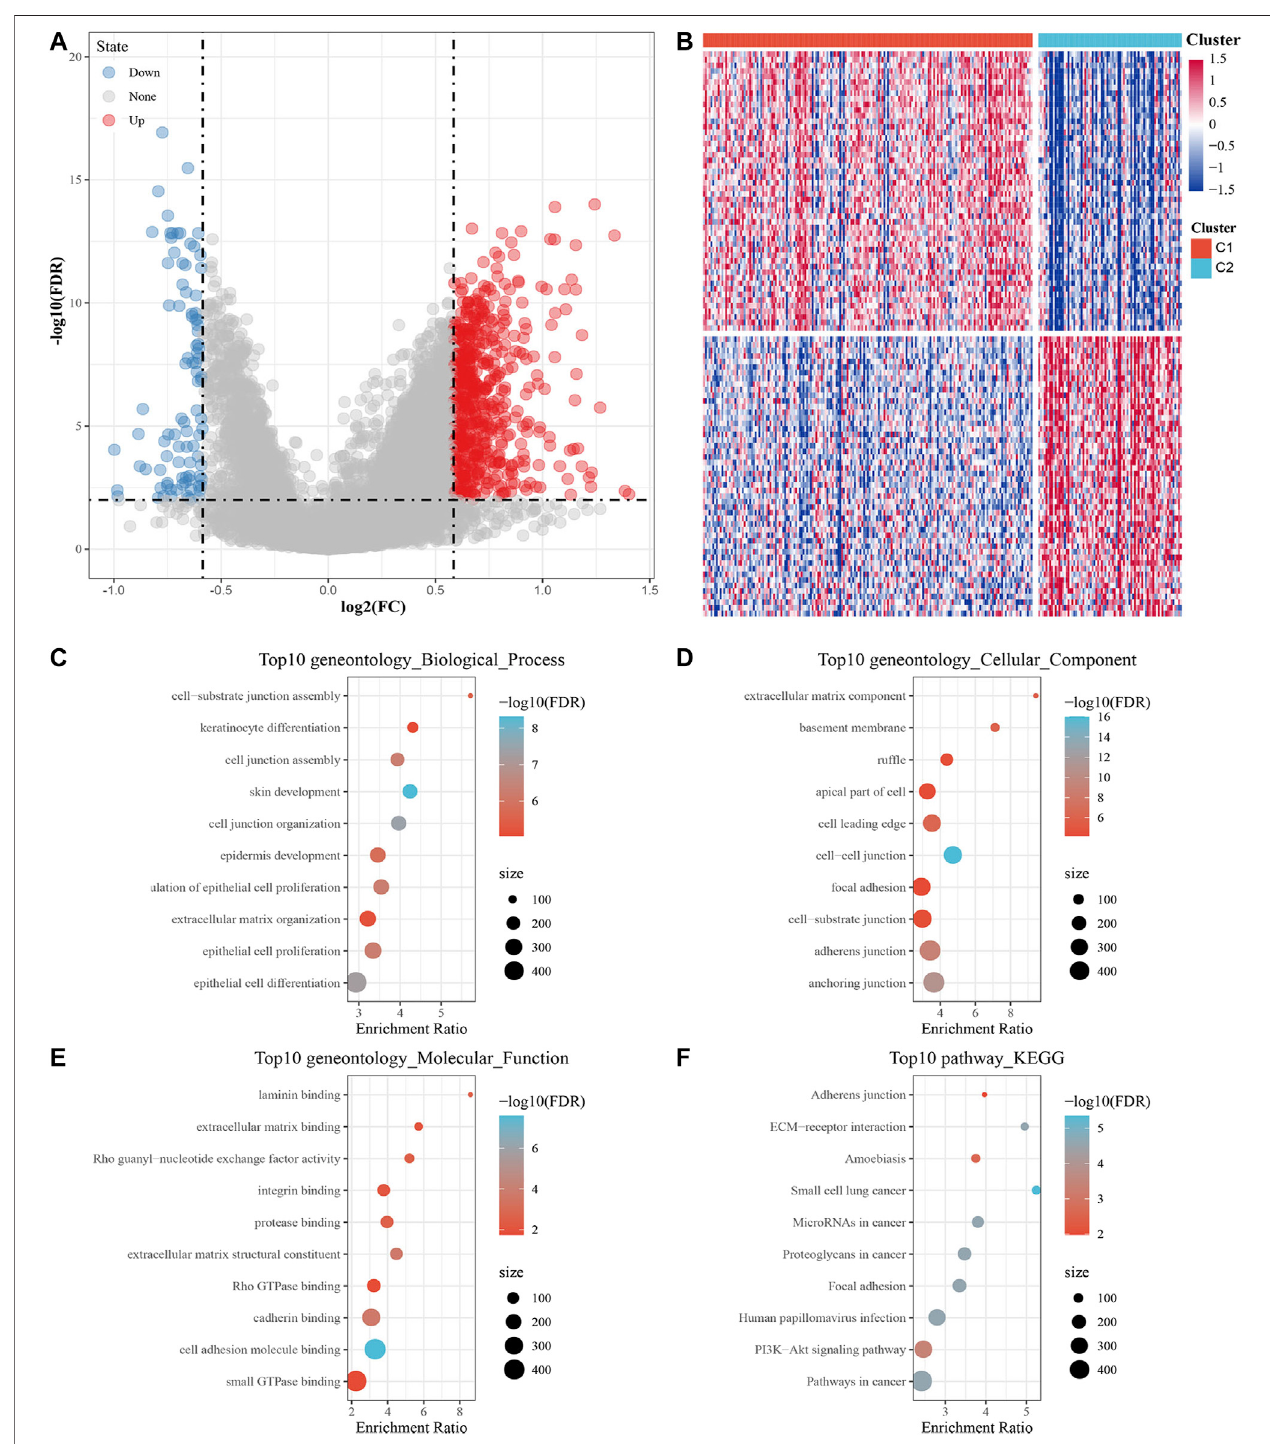
FIGURE 4| Screening DEGs between m5C subtypes and functionalanalysis. (A) Volcano map of DEGs between the C1 and C2 subtypes. (B) Heat map of DEGs between the C1 and C2 subtypes. (C – E) The results of GO enrichment analysis of the upregulated DEGs are shown by bubble chart: (C) biological processes, (D) cell composition and (E) molecular function. (F) KEGG enrichment analysis of upregulated DEGs.